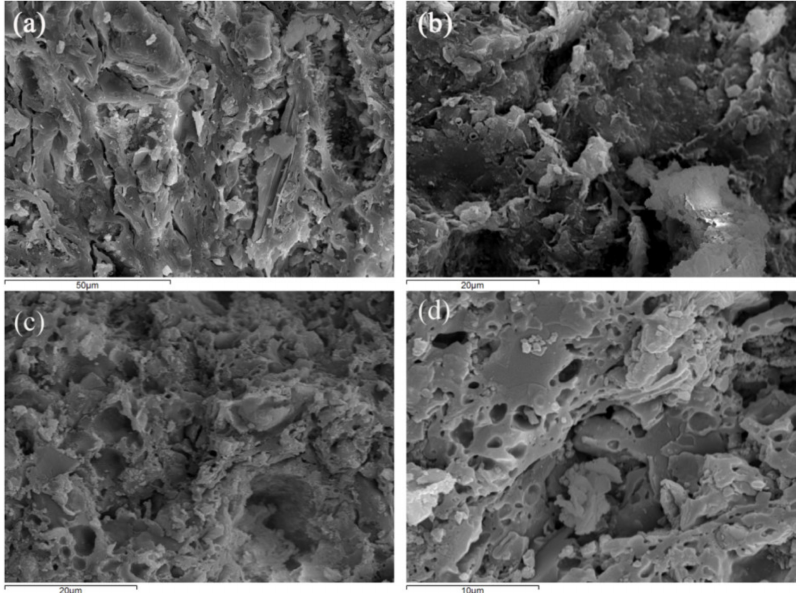
Figure 11. Secondary electron micrographs of fresh fractures from representative samples of the low calcareous ceramic samples (representative samples): ( a ) K4, ( b ) K6, ( c ) K22 and ( d )